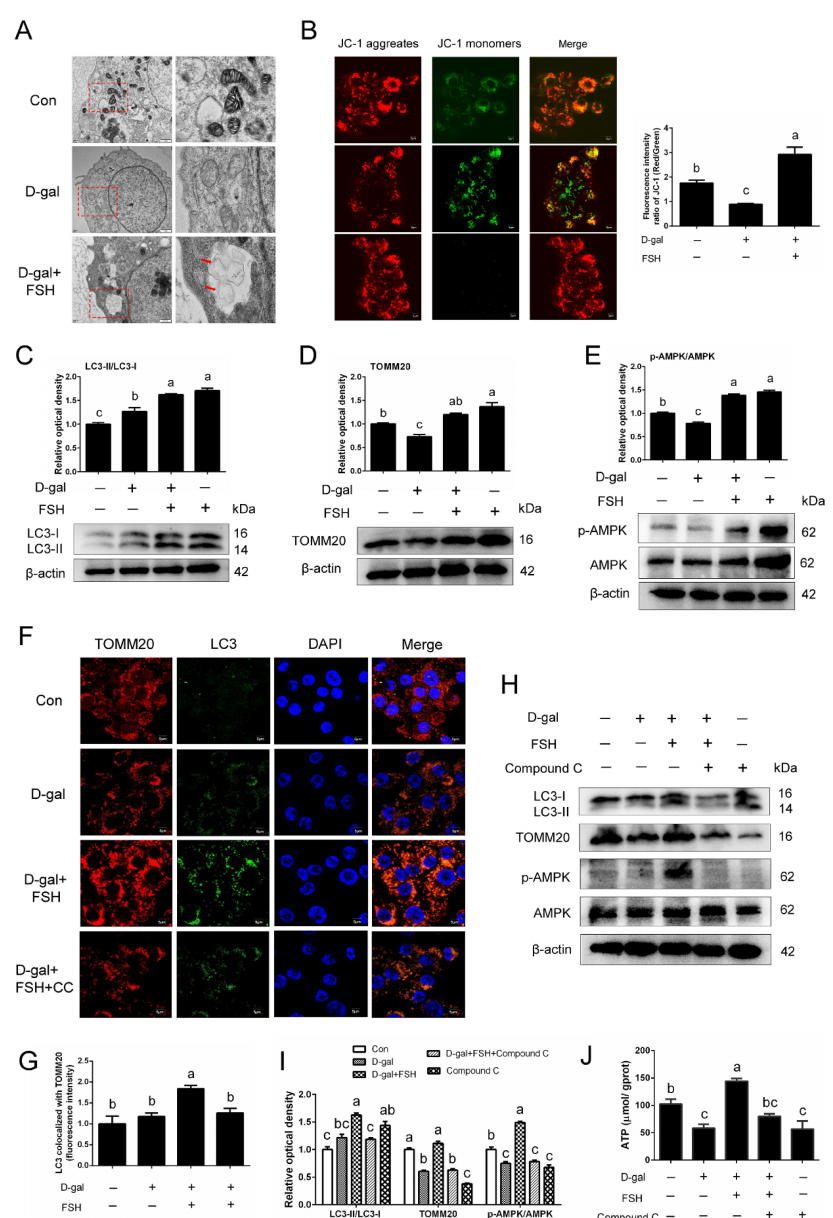
Figure 5. Activation of the AMPK signaling pathway is responsible for FSH-induced mitophagy in senescent GCs. The SYF-GCs of D280 hens were treated with D-gal (200 mM) for 24 h and were induced to become premature senescent GCs. Subsequently, 0.01 IU/mL of FSH was added and stimulated the premature senescent GCs for 24 h. ( A ) Transmission electron micrograph of mitophagosomes (red arrows) in the senescent GCs with FSH treatment. Swollen mitochondria were observed in the D-gal group, whereas this damage was alleviated after FSH addition. Scale bars: 1 µ m and 500 nm. ( B ) GCs were collected for JC-1 staining to observe the healthy mitochondria (uptaking red fluores- cent aggregates of JC-1) and defective mitochondria (uptaking green fluorescent monomeric JC-1). ( C , D ) Western blot and quantitative analyses of LC3-II and TOMM20 expression in normal, D-gal, D-gal + FSH, FSH alone-treated GCs. ( E ) Western blot and quantitative analyses of AMPK phosphorylation in GCs (normal, D-gal, D-gal + FSH, FSH). ( F , G ) Colocalization of mitophagic markers (LC3 and TOMM20) in GCs treated as indicated above. CC: Compound C. Scale bar: 5 µ m. ( H , I ) Western blot analysis of p-AMPK/AMPK, LC3-II, TOMM20 proteins in normal, D-gal, D-gal + FSH, D-gal + FSH +Compound C (AMPK inhibitor), Compound C groups. ( J ) ATP levels of GCs that were treated as indicated above ( H ). Different lowercase letters indicate significant differences ( p <